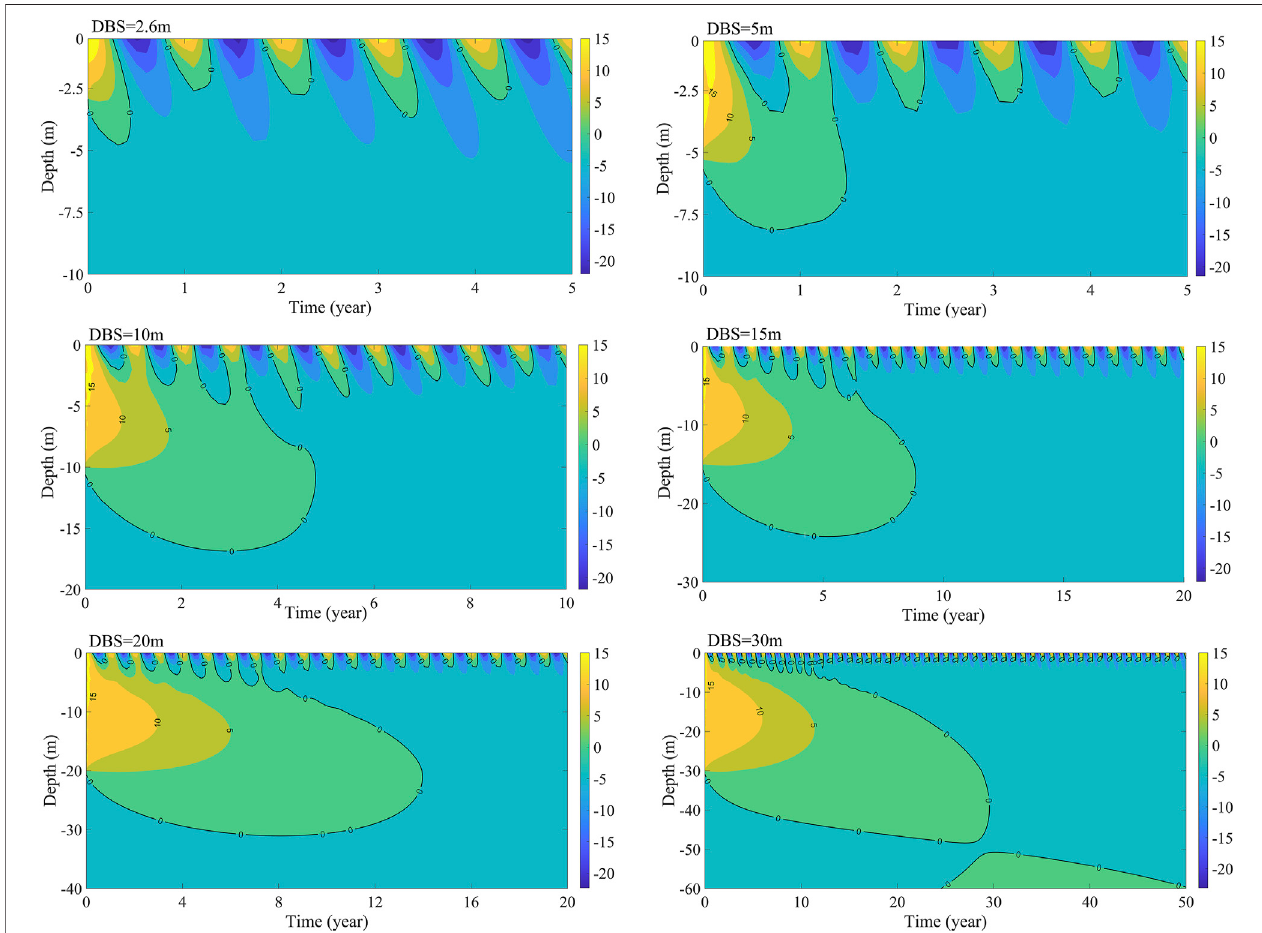
FIGURE 8 | Temporal variations in back fi ll centerline temperature under different depths of back fi ll soils (DBS at 2.6, 5, 10, 15, 20, and 30 m).